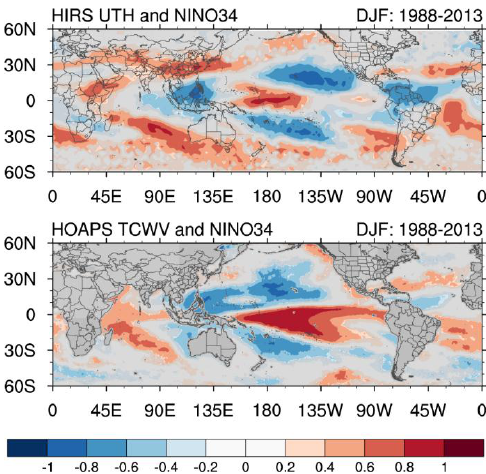
Figure 7. Correlations between the Niño 3.4 index and HIRS UTH ( upper panel ) and between the Niño 3.4 index and HOAPS TCWV ( lower panel ) for December, January, and February (DJF). Gray shading masks those correlations that are not statistically significant at the 95% level.